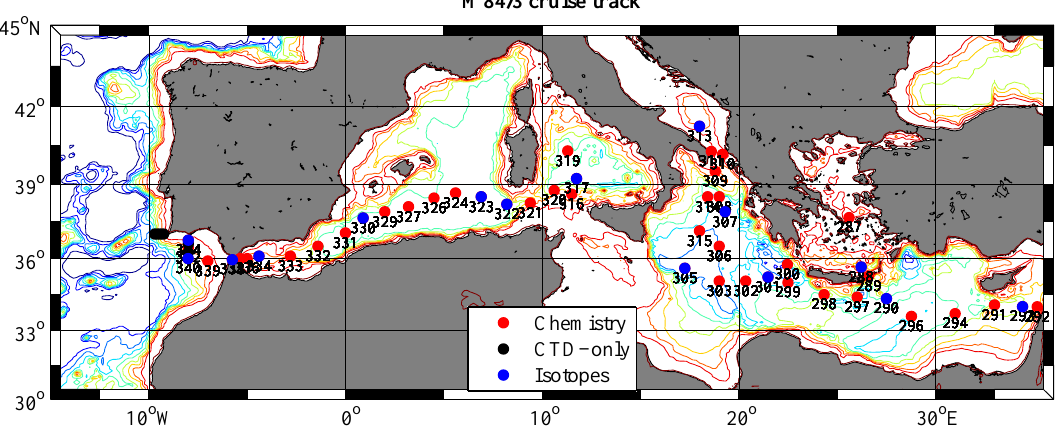
Figure 1. Cruise track of M84 / 3 with CTD stations marked in di ff erent colors based on the extent of measurements carried